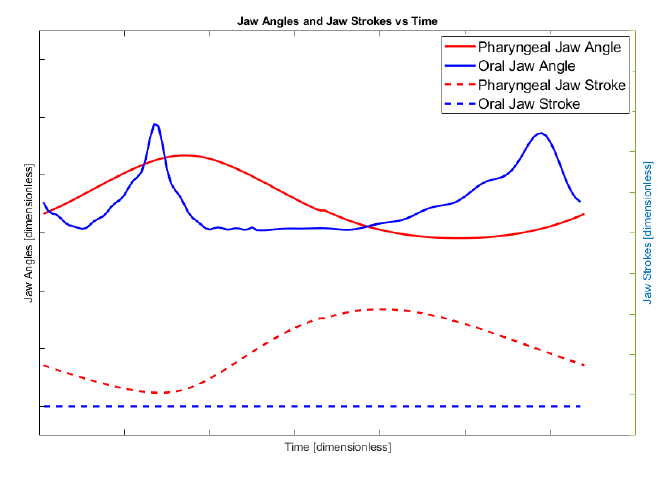
Figure 17. Resultant position and angle for both jaws.